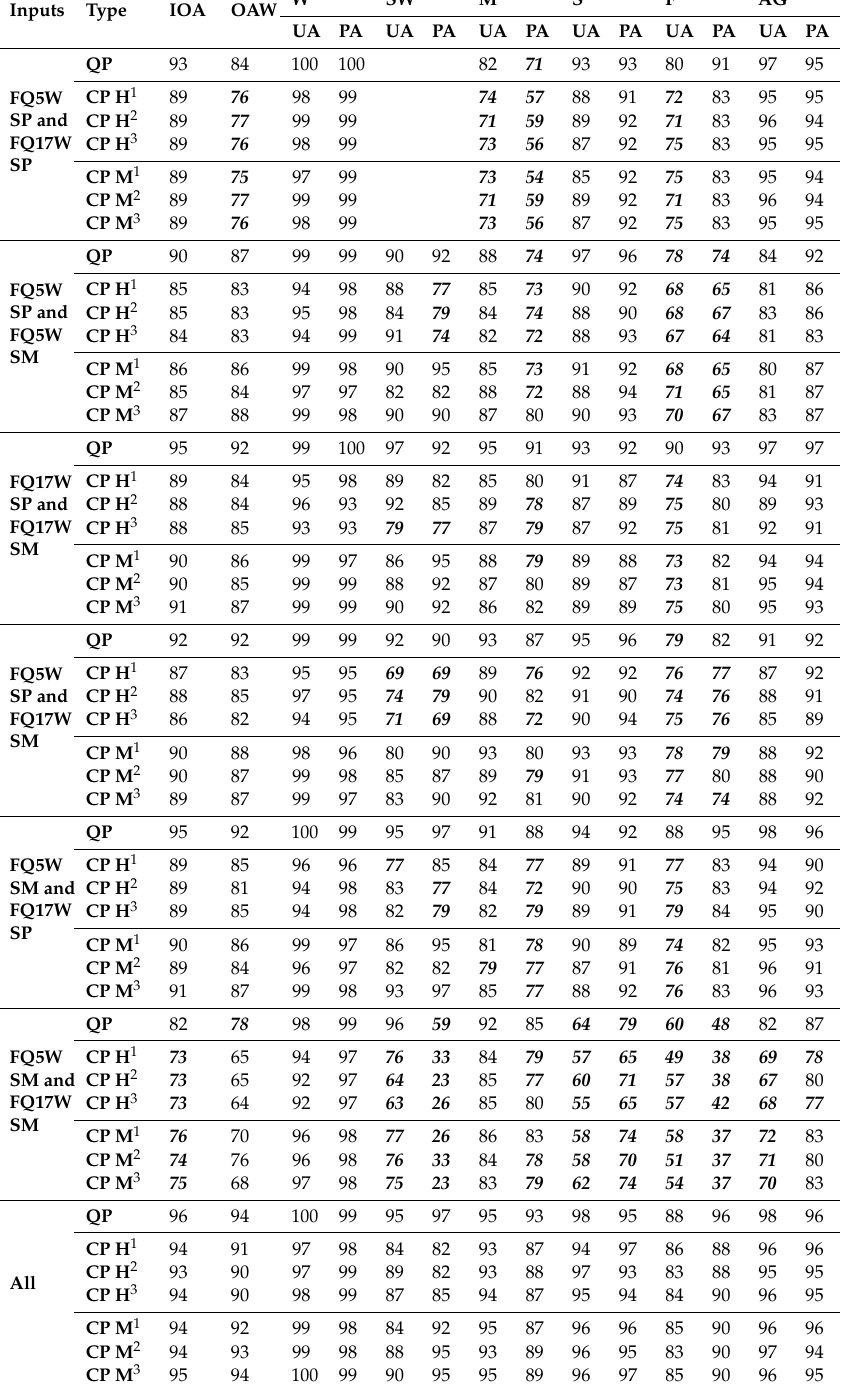
Table A1. Independent overall accuracies (IOA), independent overall accuracies for wetlands only (IOAW), and user’s (UA) and producer’s (PA) accuracies for models based on multi-angle/temporal QP, and the first (1), second (2), and third (3) simulations of high (H) and medium (M) resolution CP SAR data. Values ≤ 80% are bolded, and italicized to identify relatively high and low accuracies for a given class. Spring and summer images are abbreviated SP and